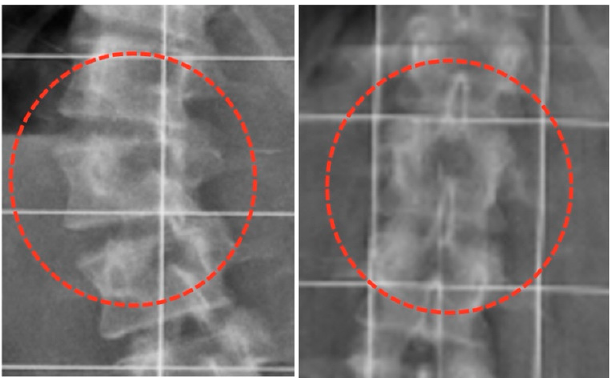
Figure 7. Modulation of the apical vertebra before surgery and after the removal of implants. The wedging ratio increased from 0.75 to